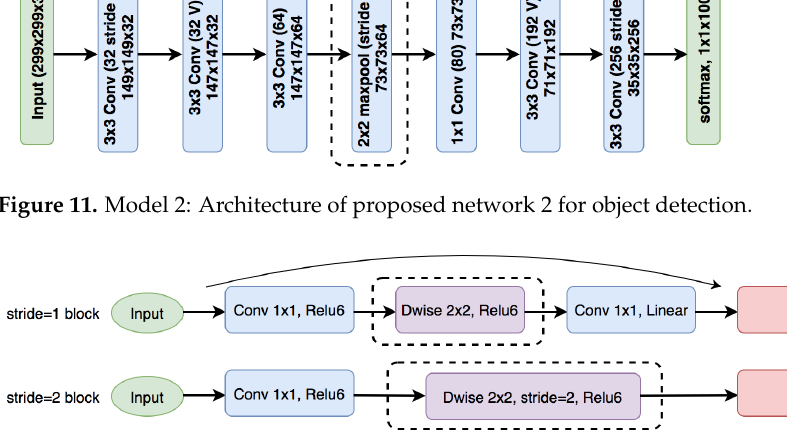
Figure 12. Model 3: Architecture of proposed network 3 for object